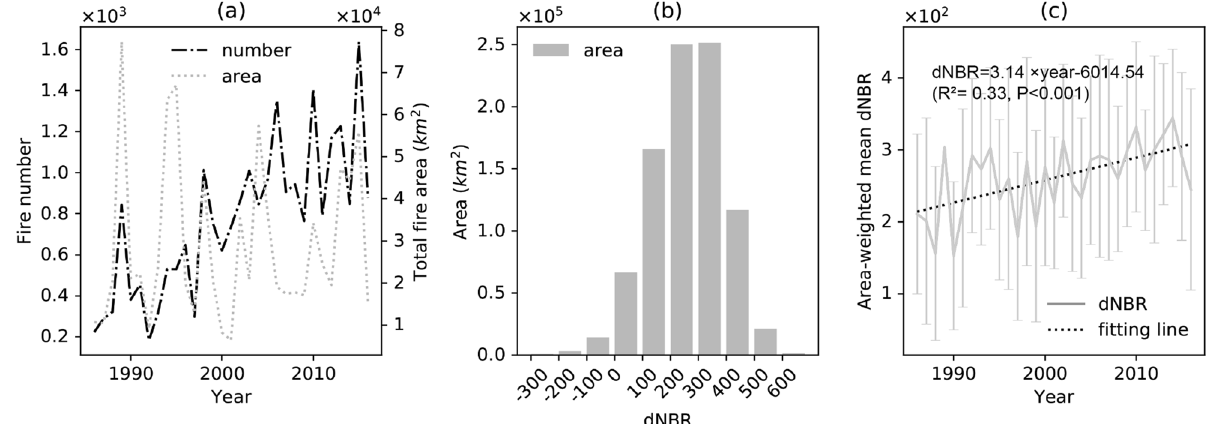
Figure 1. Summary of the fire regime during 1986–2016 in NA boreal forests: ( a ) variations of the fire area and fire number. ( b ) Histograms of dNBR (difference Normalized Burn Ratio), i.e., burn severity. The heights of grey bars are the total area of fires in which average dNBR is within the threshold indicated by the x axis. ( c ) Annual dNBR variation and trend of the fires. The grey line represents the mean while error bars represent the standard deviation. The mean values are linearly regressed to generate the fitting line.